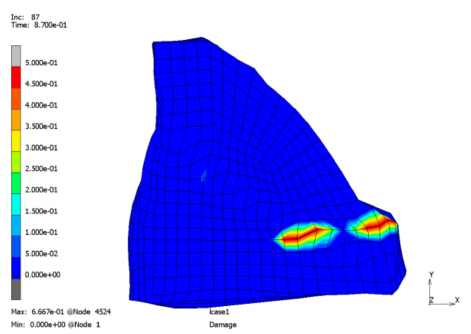
Figure 12. Forming process using a simplified geometry (backside of Figure 11b): joining zone damage.